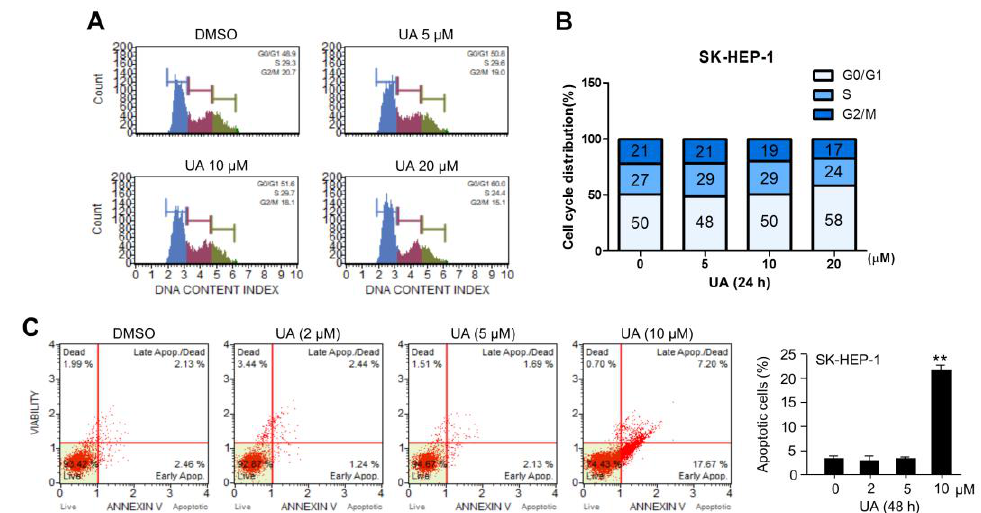
Figure 5. UA causes cell cycle arrest and apoptotic death in HCC cells. ( A , B ) SK-HEP-1 cells were incubated for 12 h with DMSO or UA at different concentrations, as indicated. Cell cycle was assessed using the Muse™ cell cycle assay kit. The values represent the mean from three independent experiments performed in duplicate. ( C ) SK-HEP-1 cells were incubated for 48 h with DMSO or UA at different concentrations, as indicated. Apoptotic cell death was measured using Muse™ Annexin V and Dead Cell kits. The values represent the mean ± SD from three independent experiments performed in duplicate; ** p < 0.01.